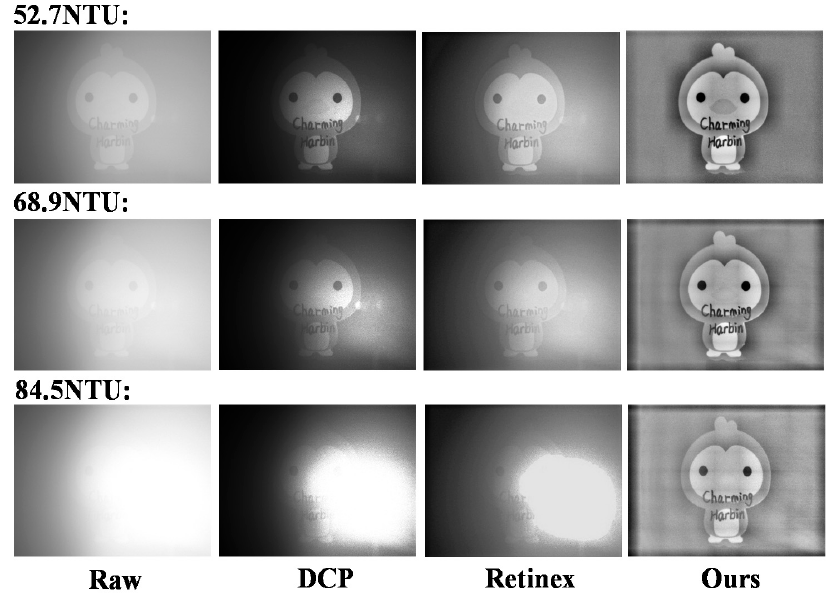
Figure 12. Comparison of the results of DCP [7,38] and retinex [39,40] at different turbidities. While our method uses only classical processing methods from non-physical and physical models, it is effective to cross them reasonably to form a new processing method to achieve target imaging in harsh underwater environments. In future work, the development from “detectable” to “better detectable” can be achieved by setting up more suitable light sources (e.g., red light [1] or circularly polarized light illumina- tion [24], etc.) and combining more advanced computational methods (e.g., computer vision [7,38–40] or machine learning [41,42],